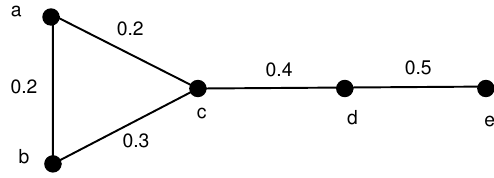
Figure 4. Fuzzy graph G with diam ( G (cid:48) ∗ ) =